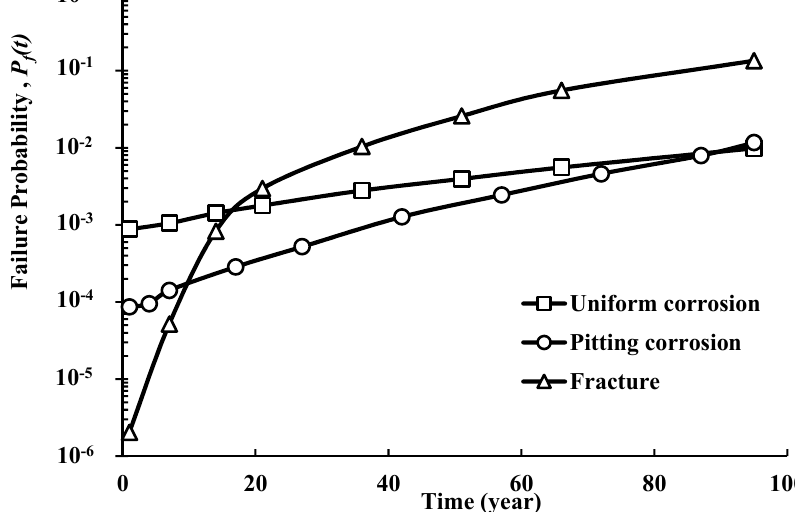
Figure 3. Time-dependent failure probability of steel bars subjected to general and pitting corro- sion.